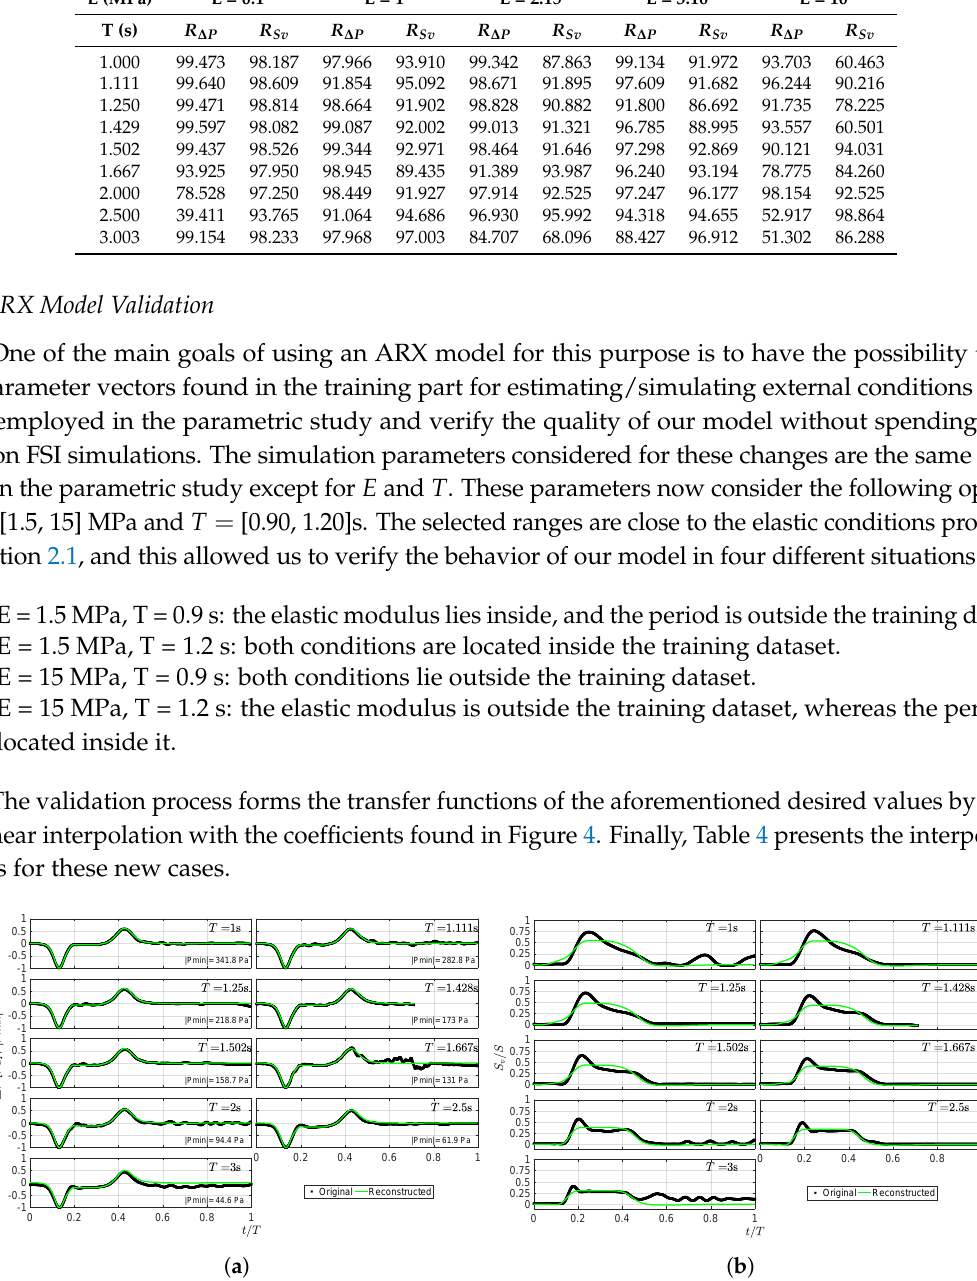
Table 3. R values obtained by the AutoRegressive with eXogenous (ARX) input model for both outputs. E (MPa) E = 0.1